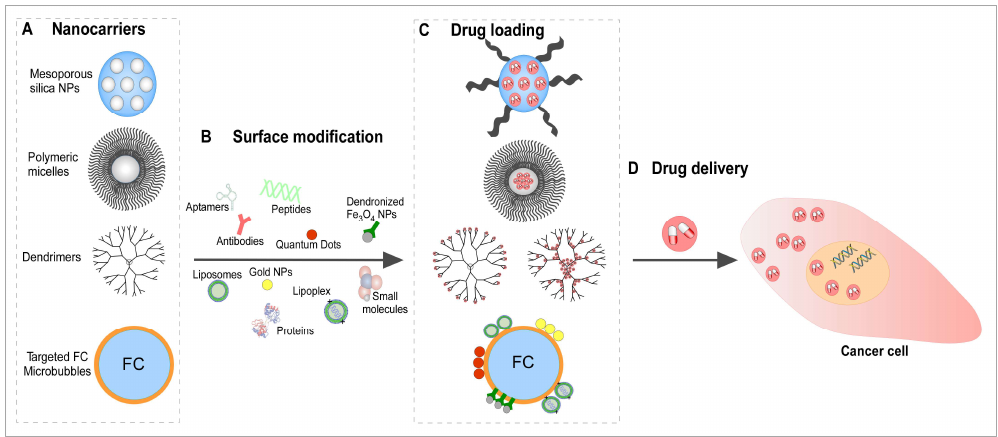
Figure 6. Illustration of drug delivery system of different nanocarriers: ( A ) Unloaded nanocarriers: Mesoporous silica NPs, polymeric micelles, dendrimers and targeted FC microbubbles. ( B ) Surface modification of nanocarriers with cancer cell specific targets (aptamers, antibodies, dendronized Fe 3 O 4 NPs, gold NPs, liposomes, lipoplex, peptides, proteins, quantum dots, and small molecules). ( C ) Illustration of drug loaded nanocarriers and drug release in cancer cells ( D ).